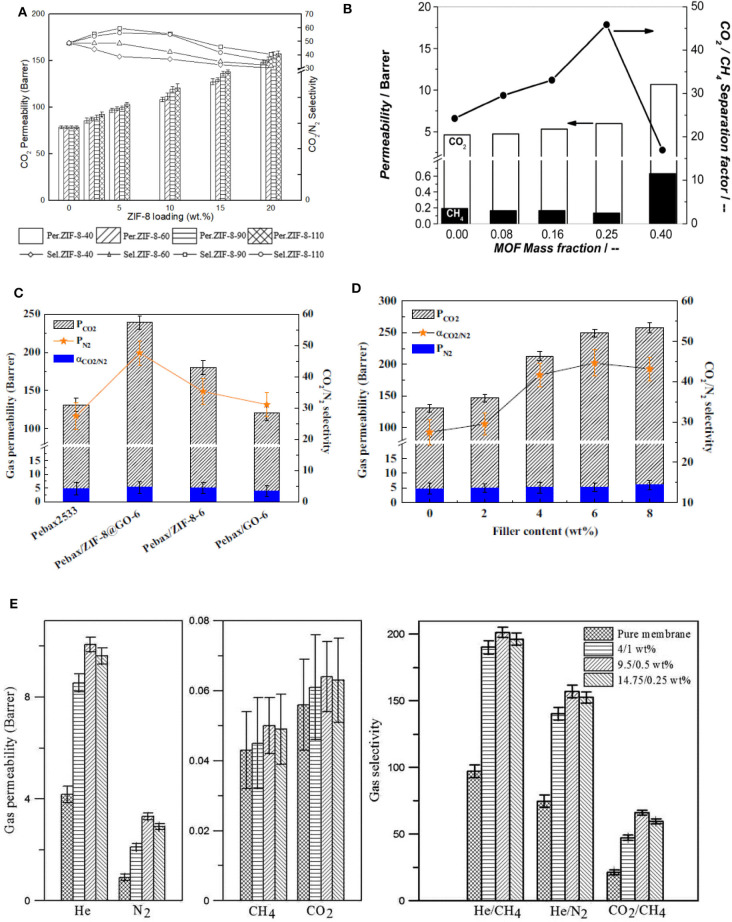
Characteristic examples of MOF filler effects: (A) Effect of ZIF-8 loading and size on CO2 permeability and CO2/N2 selectivity of Pebax-ZIF-8 MMMs. Reproduced from Zheng et al. (2019) with permission from Elsevier. (B) Separation performance of various NH2-MIL-53(Al) MMMs with different MOF loadings at 308 K for a mixture CO2:CH4 = 1:1. Pperm = 1 bar, Pret = 4 bar. CH4 (black bars) and CO2 (white bars) permeability (left y-axis) and CO2/CH4 separation factor (right y-axis). 1 Barrer = 3.348 × 10−19 kmol m/(m2 s Pa). Reproduced from Zornoza et al. (2011a) with permission from RSC. (C) Effect of different Pebax fillers, namely, MMMs with ZIF-8@GO, ZIF-8 and GO, and (D) filler content in Pebax/ZIF-8@GO MMMs. Reproduced from Dong et al. (2016a) with permission from Elsevier. (E) Gas permeability and selectivity of MMMs with different CuBTC/GO loadings. Reproduced from Feijani et al. (2018) with permission from RSC.